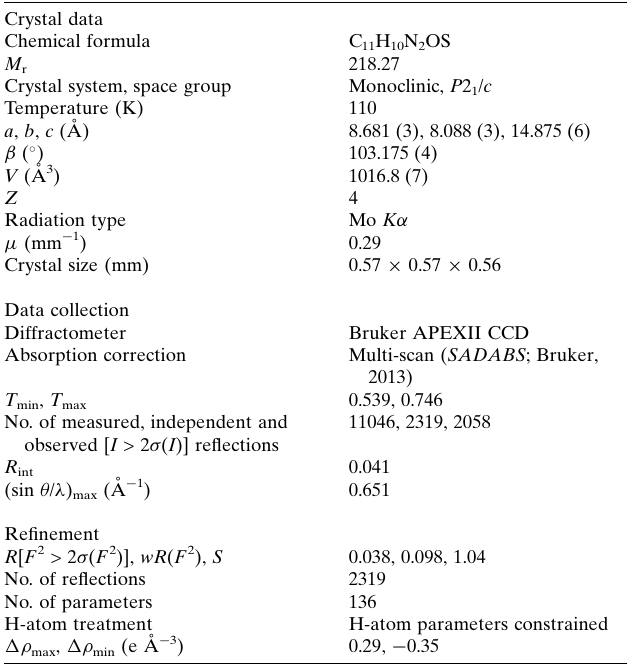
Table 2 Experimental details.